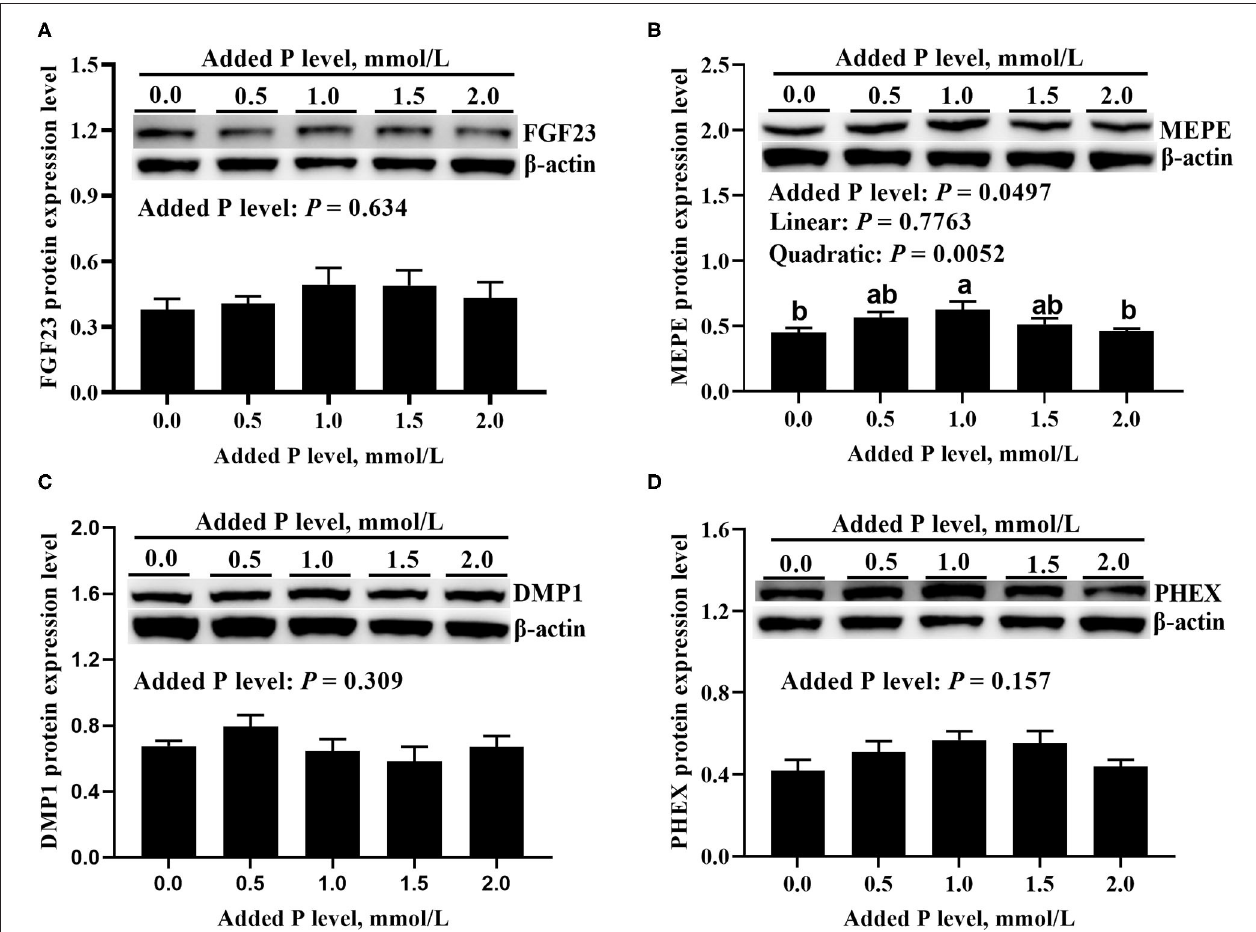
FIGURE 4 | Effect of added P level on the protein expression levels of FGF23 (A) , MEPE (B) , DMP1 (C) , and PHEX (D) in primary cultured tibial osteoblasts of broiler chicks. Representative western blots for these proteins were shown. Each value was mean ± SE, n = 6. Means without a common letter differ, P ≤ 0.05. FGF23, fibroblast growth factor 23; MEPE, matrix extracellular phosphoglycoprotein; DMP1, dentin matrix protein 1; PHEX, phosphate-regulating gene homologous to endopeptidase on X